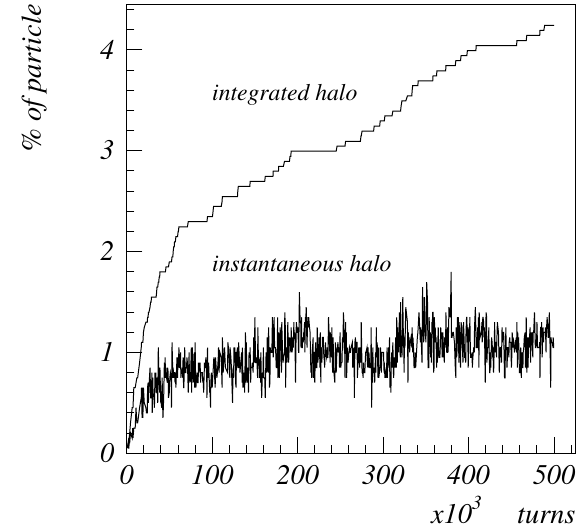
FIG. 10. Instantaneous and integrated halo intensity as a function of the number of turns for Q